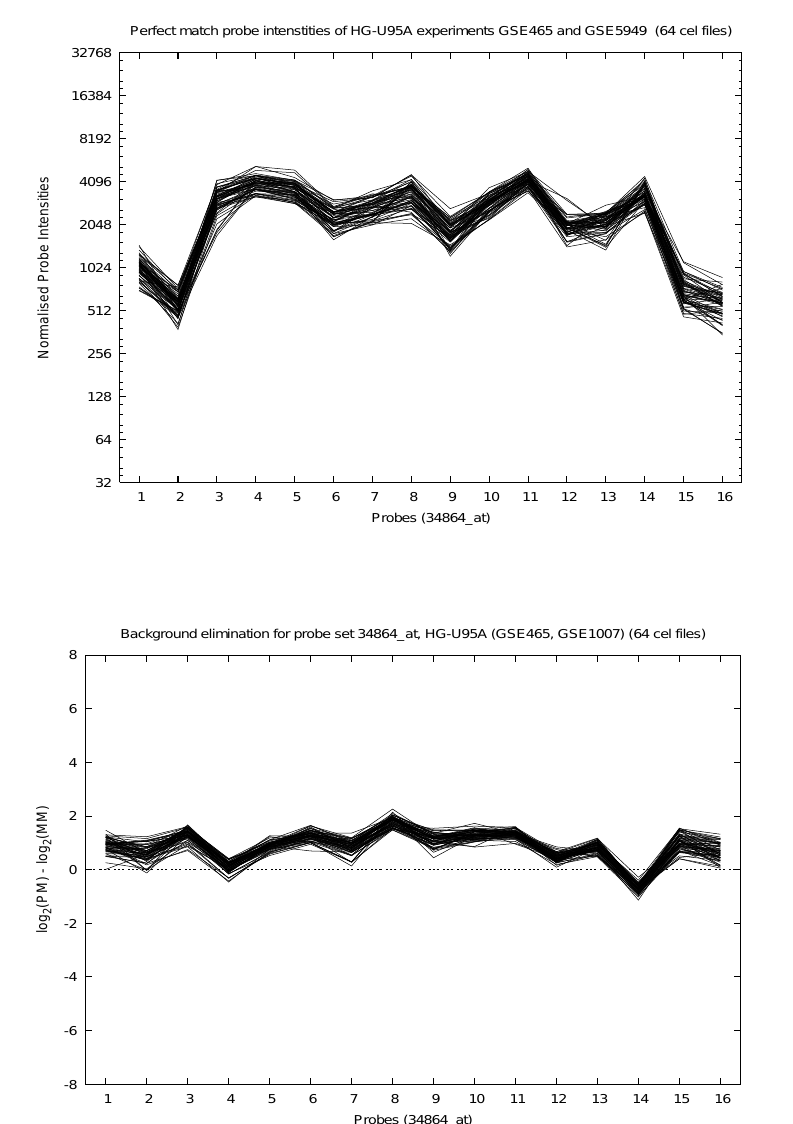
Figure 5: Probe intensities for experiments GSE1007 and GSE465 of probe set 34864 at on the HG U95A array (A) Perfect match intensities (log scale) (B) Background elimination (log 2 (PM) - log 2